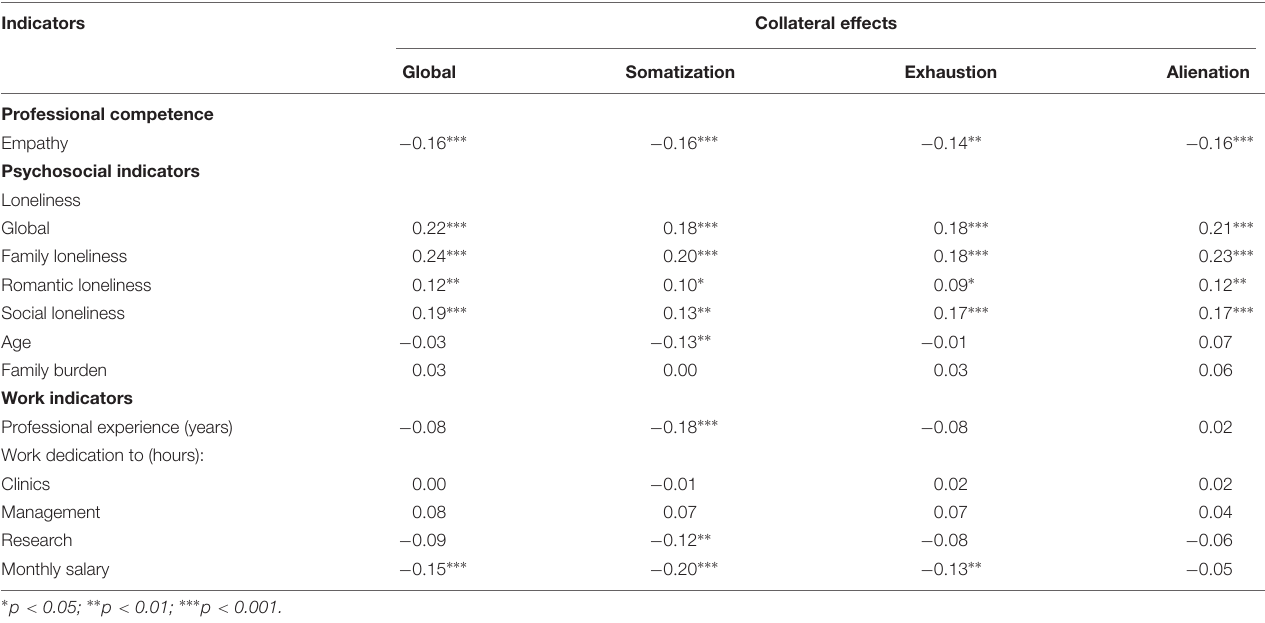
TABLE 2 | Pearson’s correlation analysis among collateral effects, loneliness, empathy, and age in Spanish healthcare professionals. Indicators